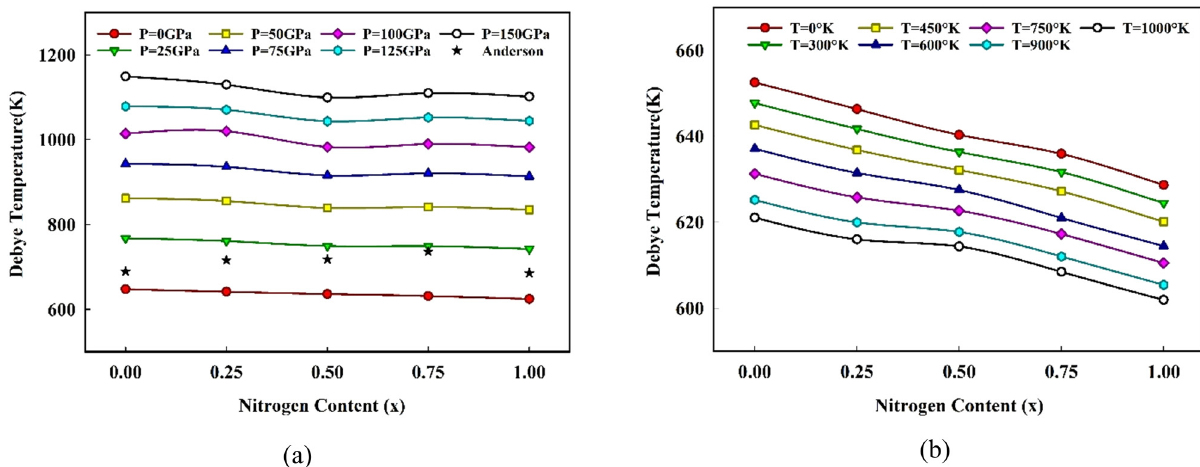
Figure 9: Debye temperature for structures of ZrC ( 1 − x ) N x as a function of nitrogen content ( x ) for ( a ) di ff erent pressures at 300 K and ( b ) di ff erent temperatures at zero